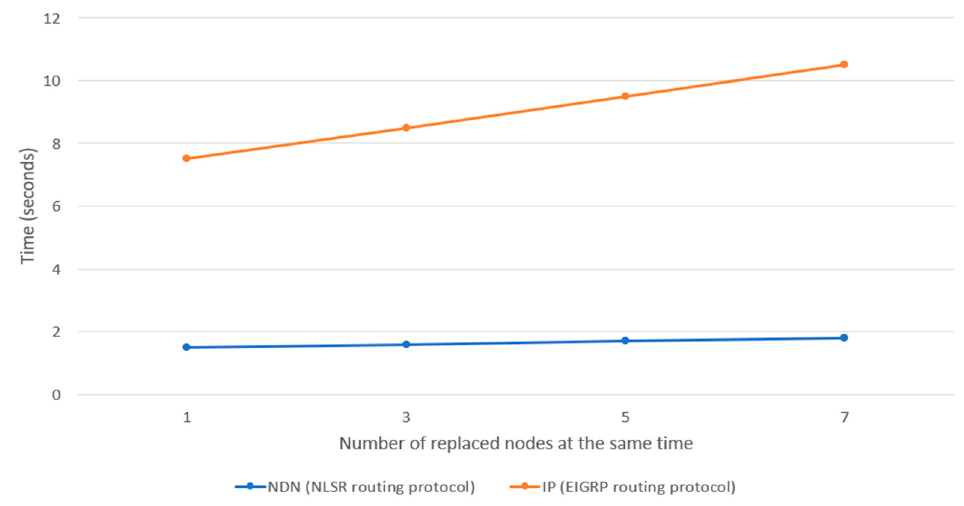
Figure 14. The comparison of network convergence time between NDN and IP network.